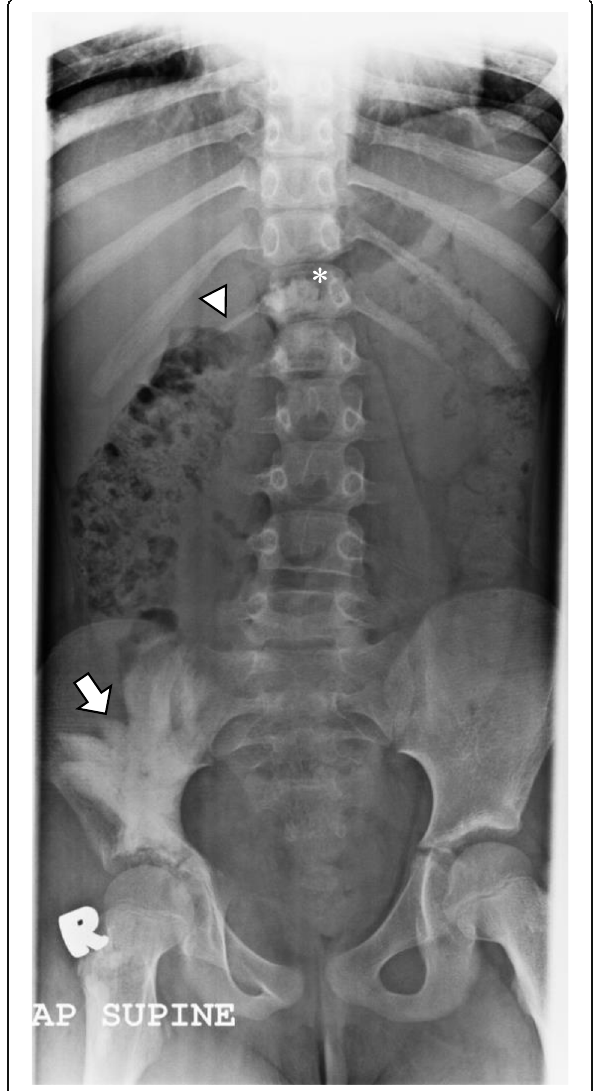
Fig. 1 Flowing candle wax appearance at the right ilium (big arrow) and T12 vertebra (asterisk) with hypoplastic right 12th rib (arrowhead) on plain